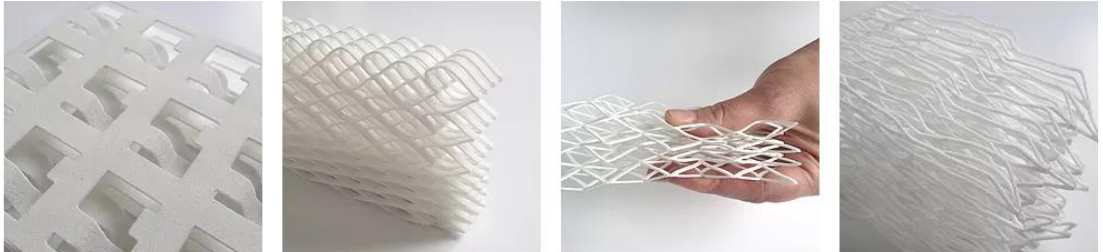
Figure 4. Series of prototypes demonstrating variations of possible structures inspired by radiolarians for application to soft seating [59].